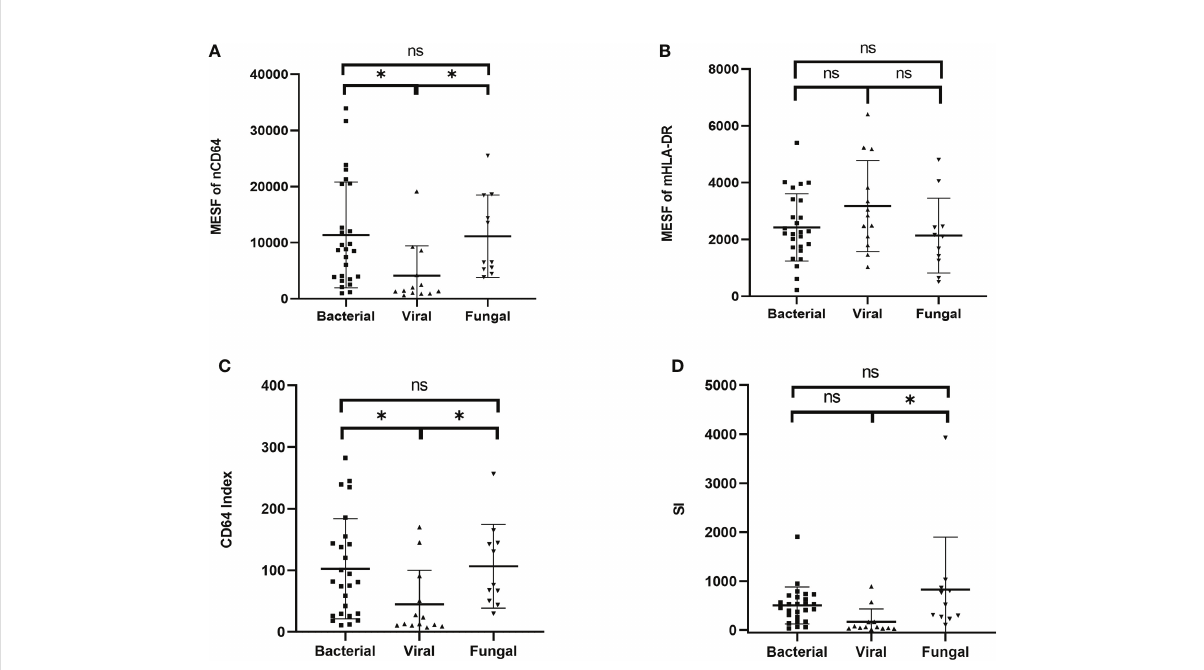
FIGURE 6 Comparison of the MESF of nCD64 (A) , MESF of mHLA-DR (B) , CD64 index (C) and SI (D) between the bacterial, the viral and the fungal infection subgroups. Tested by the least signi fi cant difference test for back testing of multivariate ANOVA. * means P < 0.05. nCD64, neutrophil CD64; mHLA-DR, monocyte HLA-DR; HC, Healthy controls; KTRs, kidney transplant recipients; MESF, molecules of equivalent soluble fl uorochrome; ns, no signi fi